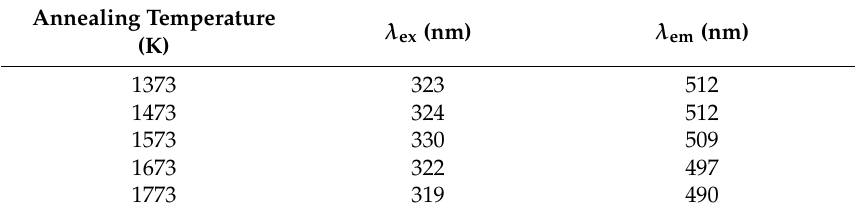
Table 1. Emission and excitation wavelengths of (Ca 1.95 Eu 2+ 0.02 (cid:3) 0.03 )(Si 0.94 P 0.06 )O 4 phosphors.